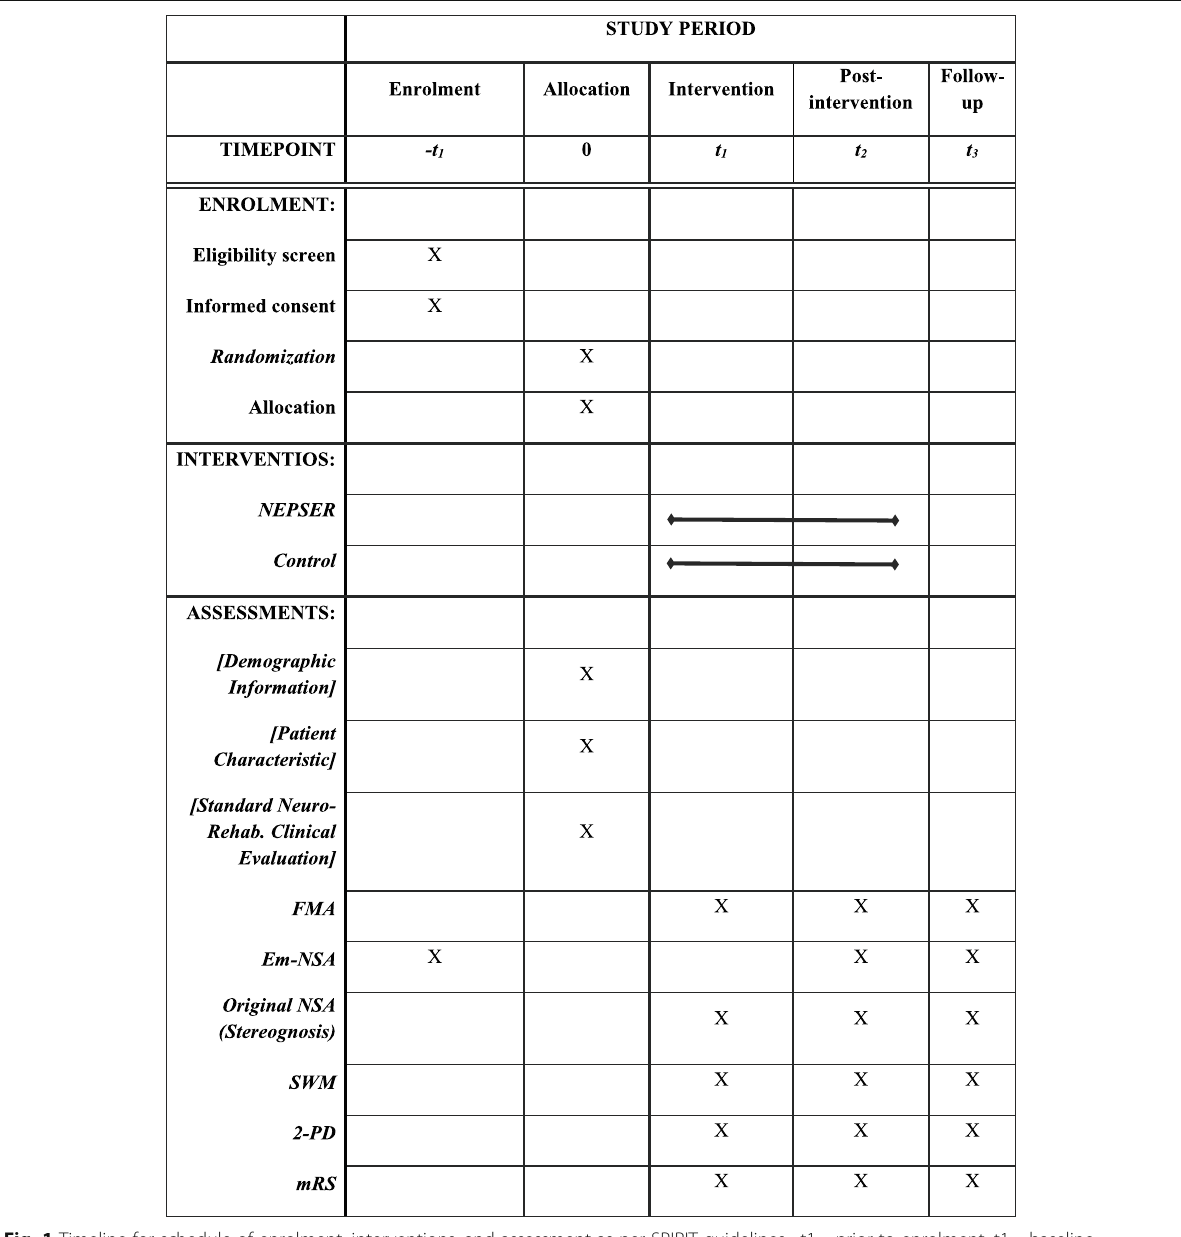
Fig. 1 Timeline for schedule of enrolment, interventions, and assessment as per SPIRIT guidelines. -t1 = prior to enrolment, t1 = baseline assessment, t2 = assessment after 8 weeks of intervention, t3 = assessment after four-week follow-up (12 weeks after start of intervention). FMA = Fugl-Meyer assessment, Em-NSA = Erasmus MC modification of the revised Nottingham Sensory Assessment, NSA = Nottingham Sensory Assessment, SWM = Semmes-Weinstein monofilaments, 2-PD = Two-point discrimination, mRS = modified Rankin scale. NEPSER= NE uroplasticity- P rinciples-based SE nsory- R